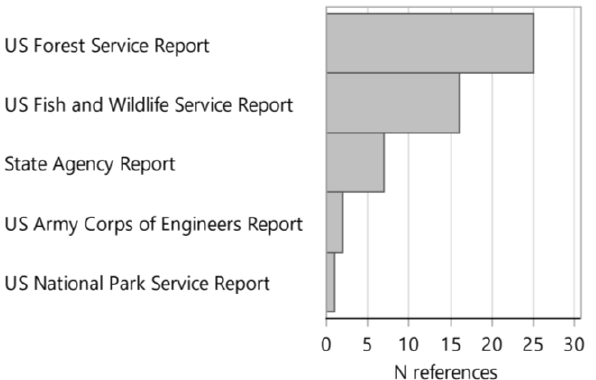
Figure 9. The 5 different agencies that produced documents grouped under the “government document” reference type.